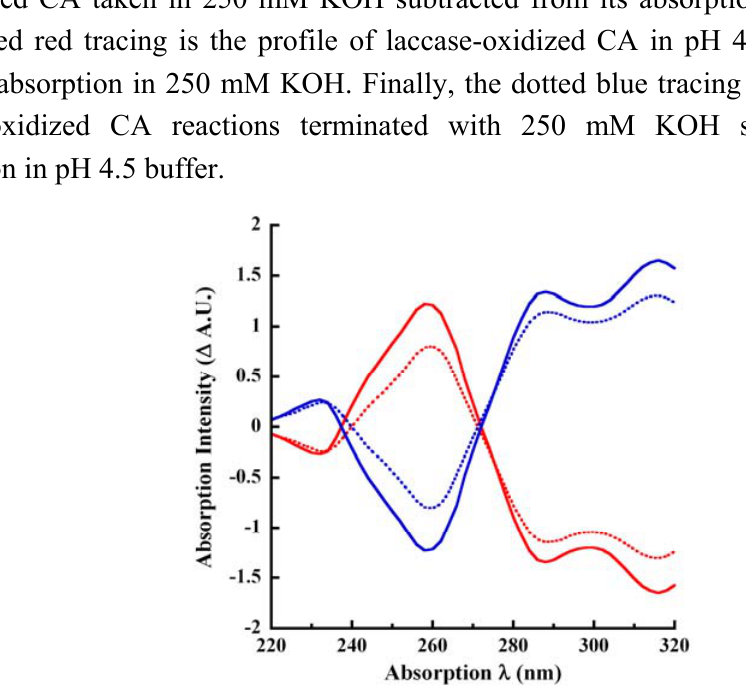
Figure 5. Difference spectroscopy of CA. Subtractive absorption profiles of unmodified CA in pH 4.5 buffer or in 250 mM KOH and profiles of 0.1 μ g/mL laccase-oxidized CA in pH 4.5 buffer (57 minutes) or in 250 mM KOH (60 minutes) are shown here. The solid red tracing represents the absorption of unmodified CA measured in pH 4.5 buffer subtracted from the absorption in 250 mM KOH. The solid blue tracing represents the absorption of unmodified CA taken in 250 mM KOH subtracted from its absorption in pH 4.5 buffer. The dotted red tracing is the profile of laccase-oxidized CA in pH 4.5 buffer subtracted from its absorption in 250 mM KOH. Finally, the dotted blue tracing is the absorption